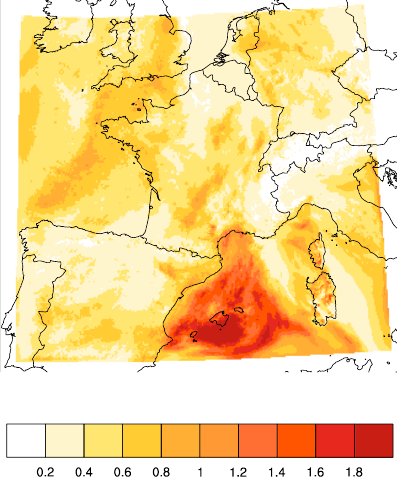
Figure 5. Background-error standard deviations of q (gkg − 1 ) for the model AROME-France, at model level 52 ( ≈ 920hPa). Stan- dard deviations are estimated from the 90-member ensemble of 3h forecasts, valid at 03:00UTC on 4 November